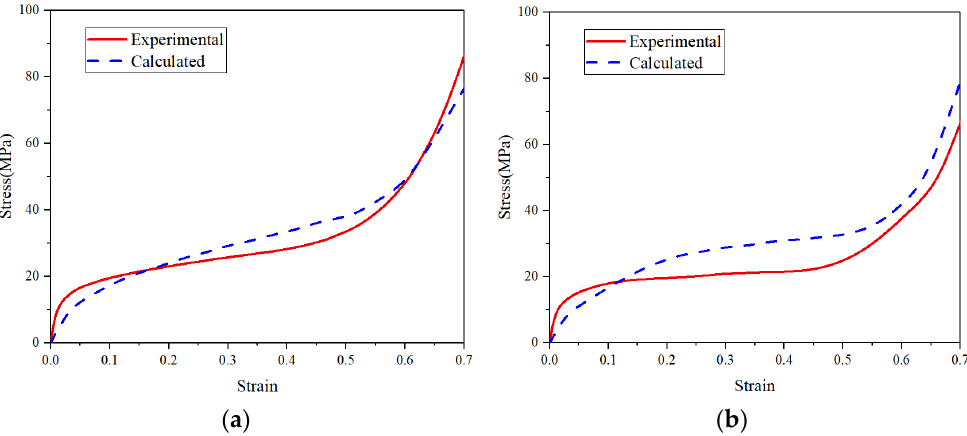
Figure 12. Comparison of experimental and calculated curves of the closed-cell copper foams with ( a ) uniform pores and ( b ) graded pores at 25 °C .